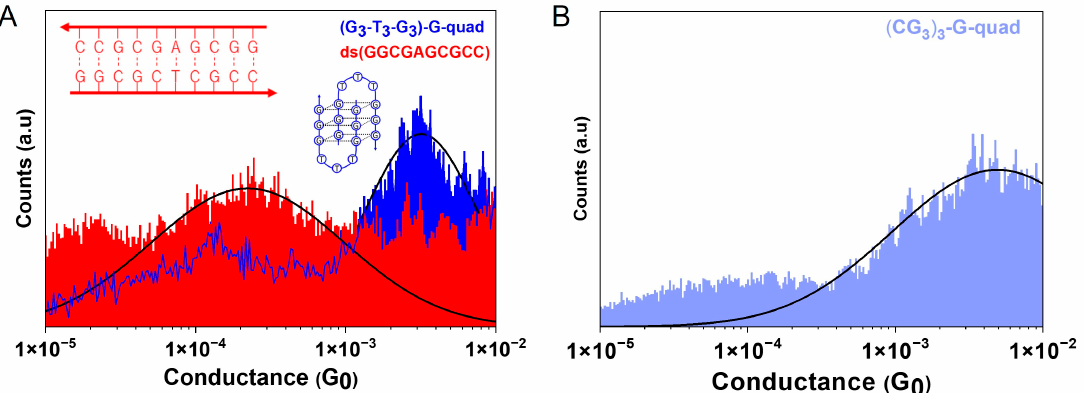
Figure 4. Break junction measurements on ( A ) 5 ′ -G 3 -T 3 -G 3 -G-quad (blue) and dsCCGCGAGCGG (red); inset: schematic representations of dsDNA and G-quadruplex. ( B ) Conductance histogram for the (CG 3 ) 3 -G-quad structure, which is obtained by hybridizing the sequence (CG 3 ) 3 without the complementary strand present.